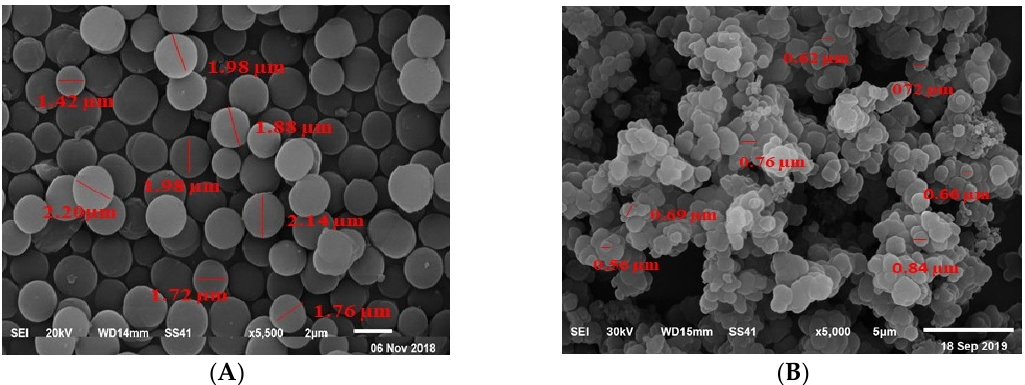
Figure 3. Scanning electron microscope ( SEM) images of ( A ) NIP beads and ( B ) washed MIP beads.